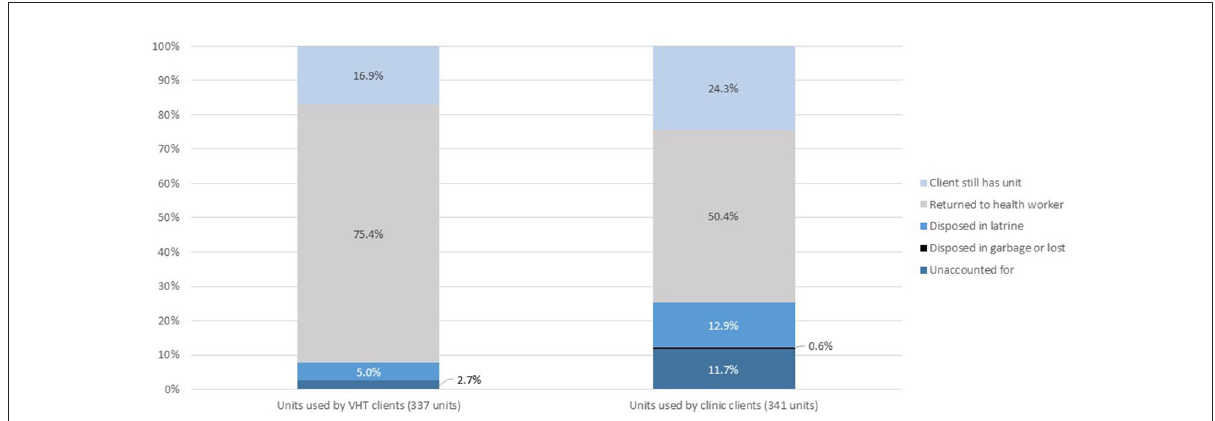
FIGURE3 Distribution of used units, by training location (clinic or